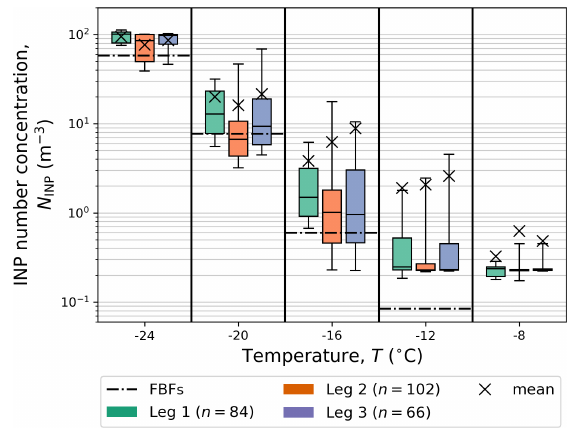
Figure 6. Mean values (crosses) and box-and-whiskers plots indi- cating the median (horizontal lines), inter-quartile range (boxes), and 10th to 90th percentiles (whiskers) of INP number concentra- tion ( N INP ) from the LV filters sampled during Leg 1 (green), Leg 2 (orange), and Leg 3 (purple). Averaging was performed by treating zero (infinite) values of N INP at given temperature as values of the lower (upper) limit of the detectable range. In the figure, the mea- surement background is represented by the averaged spectra of the field blank filters (FBFs; dashed–dotted lines), and the number of data points ( n ) are